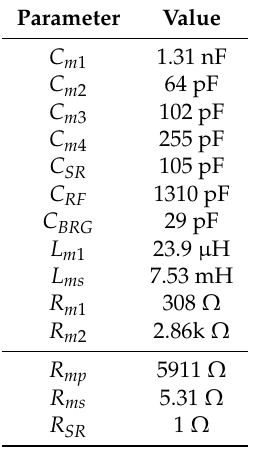
Table 1. Common-mode impedance model parameters of a 7.5 kW motor with hybrid bearings 6308-2RS (ZCS